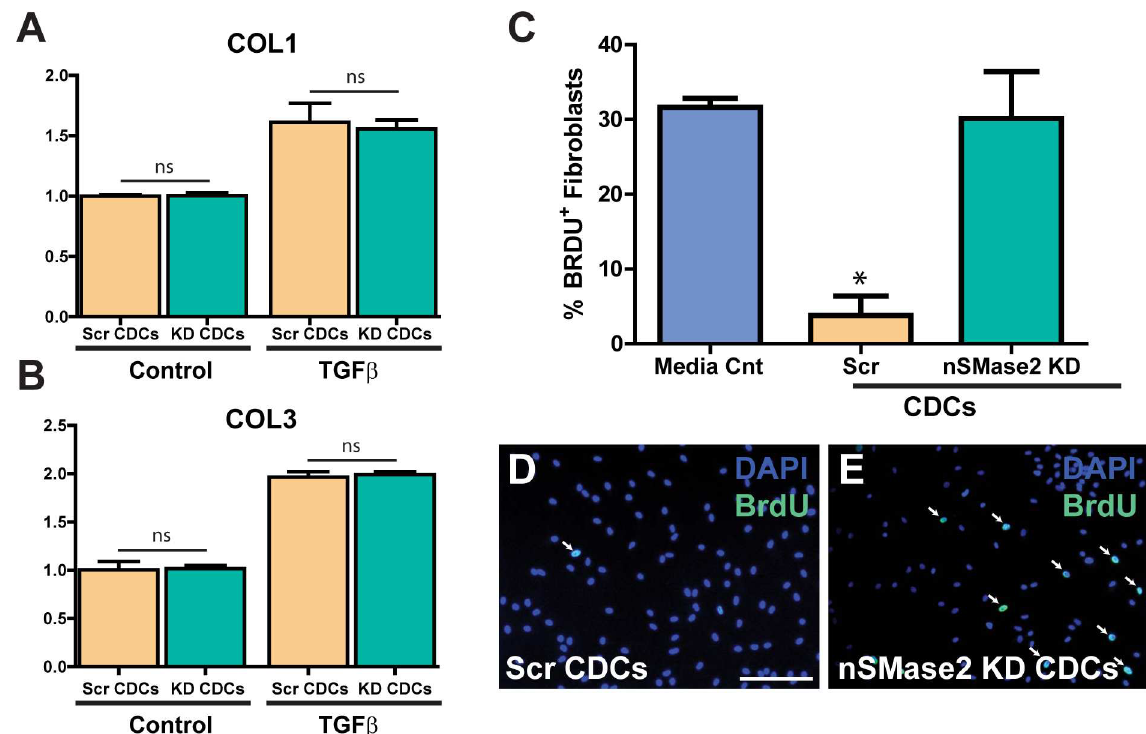
Fig 8. hCDC exosomes reduce proliferation of cardiac fibroblasts without affecting collagen gene expression. (A, B) Human quiescedcardiac fibroblasts cocultured with either Scr CDCs or KD CDCs showed no statistically significant difference in COL1 or COL3 gene expressionby qRT-PCR followingTGF β stimulation (n = 3). Data normalizedto unstimulated Scr CDCs. (C, D) Cardiac fibroblasts cocultured with Scr CDCs for 24 hours showed a significant reduction in cellular proliferation as assessed by BrdU staining (5 hour pulse) when comparedwith (C, E) cardiac fibroblasts coculturedwith nSMase2 KD CDCs and media control. n = 3. Scale bar 200 μ m. * p < 0.05 using one-way AVOVA (Tukey’s post hoc test). Data are presented as mean ± SEM. White arrows highlightcells that co-stain for DAPI and